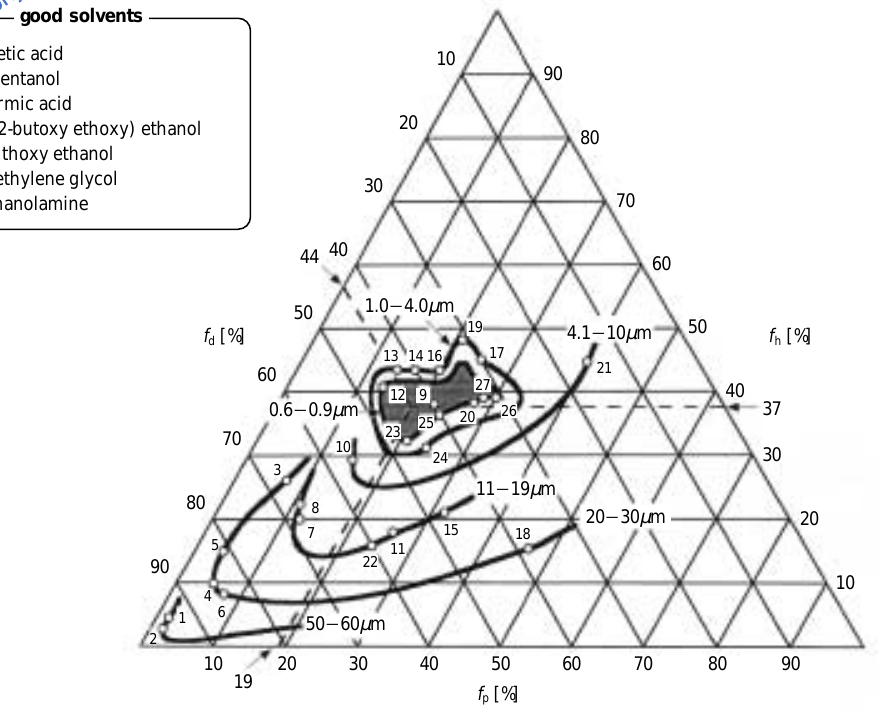
Fig. 3 Isometric particle lines on triangular chart for Al 2 O 3 (Each number means a solvent listed in Table 1 )